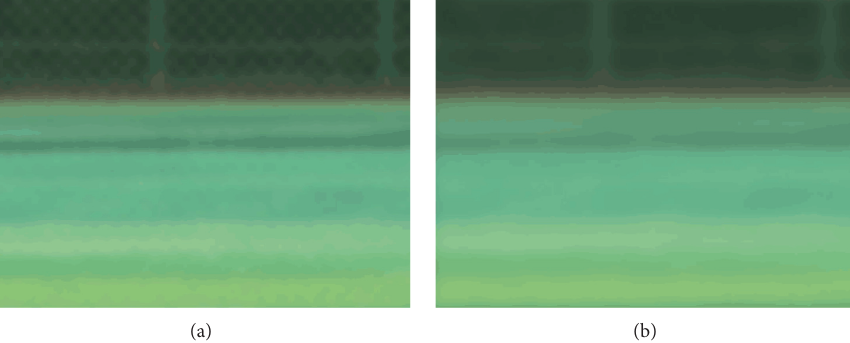
Figure 7: The comparison charts of RONI in detail. The compressed result of (a) K0103 algorithm and (b) ORC